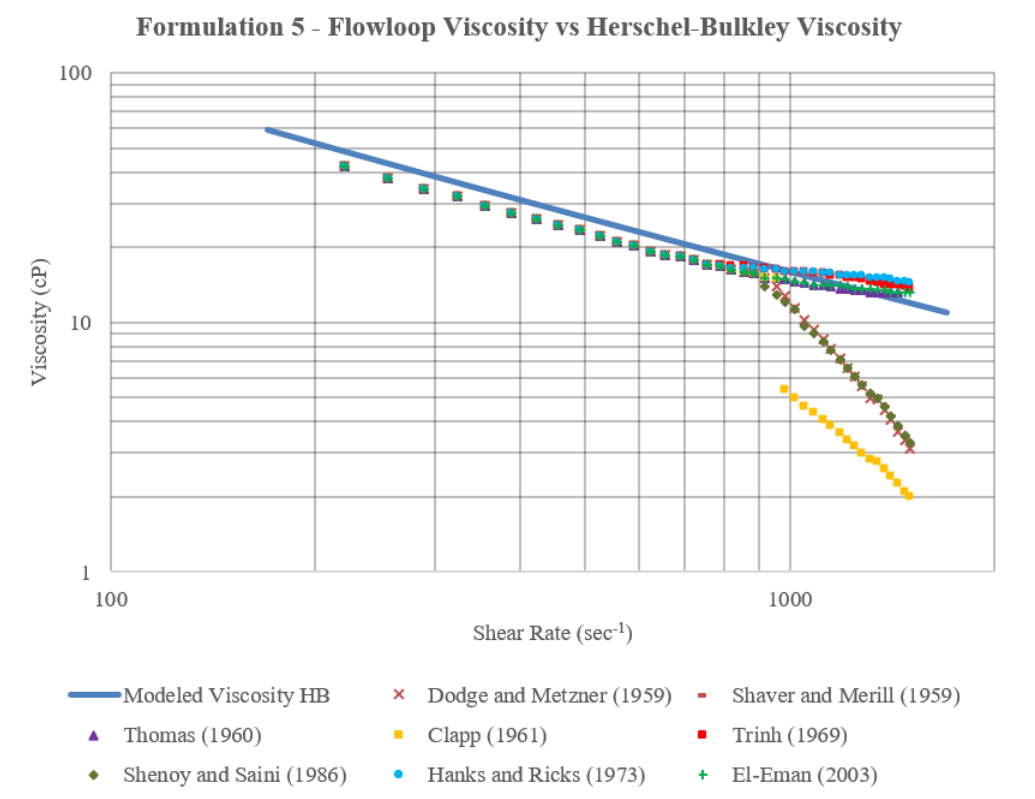
Figure 5: Estimated viscosity of Formulation 5 from flowloop data using different friction factor models given in Table A1